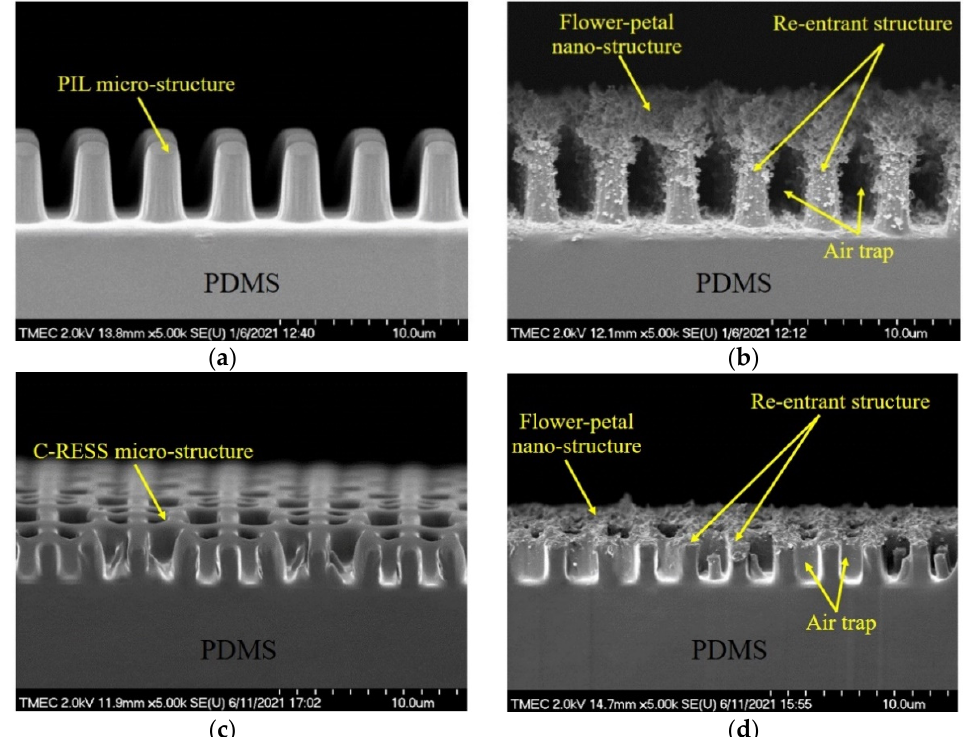
Figure 5. Side − view SEM images of untreated and flame − treated PDMS patterns and Teflon surfaces Figure 5. Side-view SEM images of untreated and flame-treated PDMS patterns and Teflon surfaces before bacterial adhesion testing: ( a ) FLT; ( b ) PIL; ( c ) C − RESS; ( d ) untreated Teflon; ( e ) FLT − F; ( f ) before bacterial adhesion testing: ( a ) FLT; ( b ) PIL; ( c ) C-RESS; ( d ) untreated Teflon; ( e ) FLT-F; ( f ) PIL-F; PIL − F; ( g ) C − RESS − F patterns. ( g ) C-RESS-F patterns.